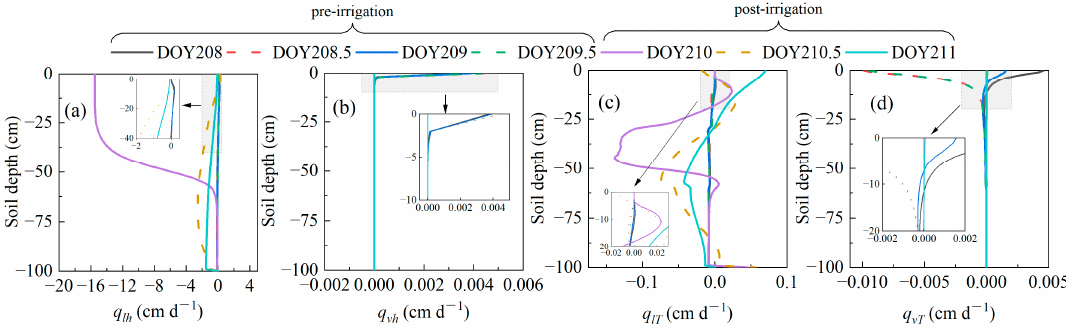
Figure 4. Simulated vertical distributions of the thermal and isothermal fluxes of liquid water and vapor during a typical period from DOY 208 to 211 (27–30 July 2013) before and after an irrigation event for SMT (irrigation starts at 16:00 h and ends at 16:40 h of DOY 209). DOY 208 means 0:00 h of DOY 208; DOY 208.5 means 12:00 h of DOY 208. DOY 208, 208.5, 209 and 209.5 were the pre-irrigation period; DOY 210, 210.5 and 211 were the post-irrigation period. ( a ) The isothermal liquid water flux ( q lh ); ( b ) the isothermal vapor flux ( q vh ); ( c ) the thermal liquid water flux ( q lT ); ( d ) the thermal vapor flux ( q vT ). All fluxes are positive upward.